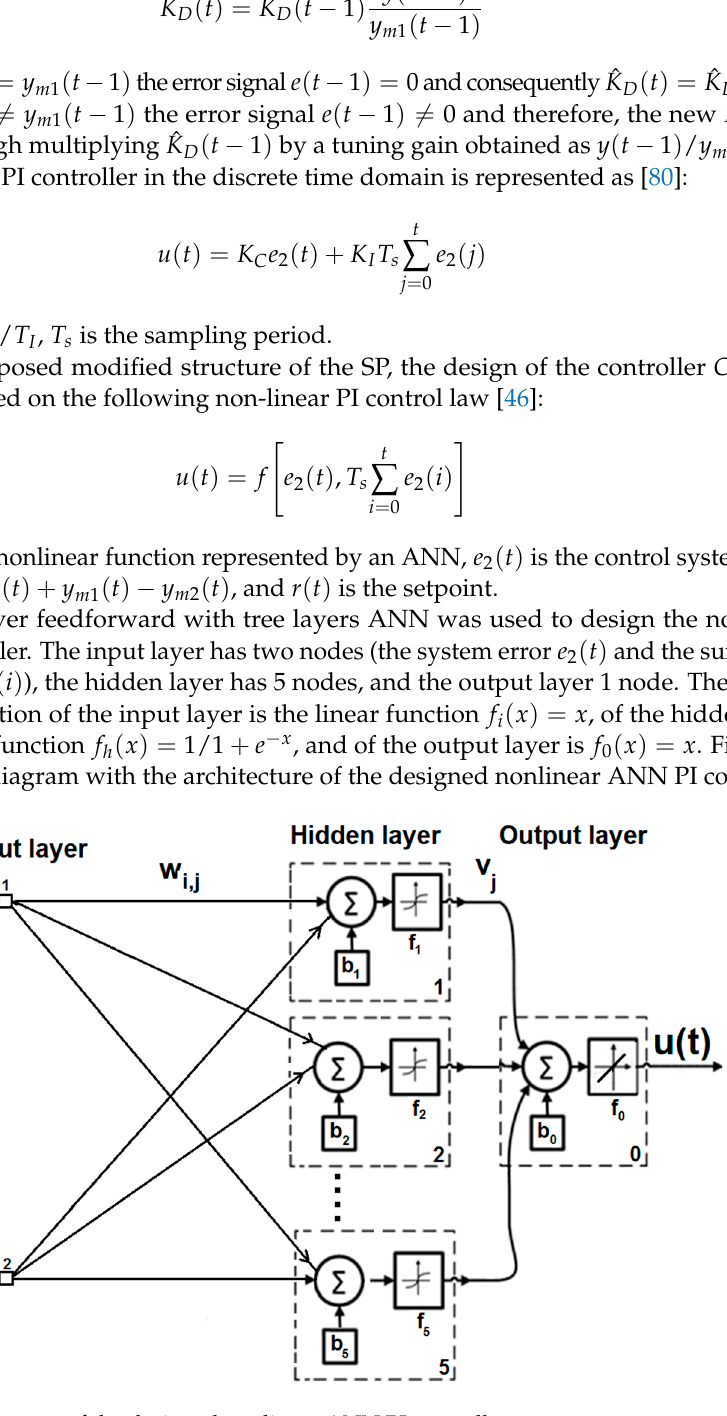
Figure 10. Architecture of the designed nonlinear ANN PI controller.